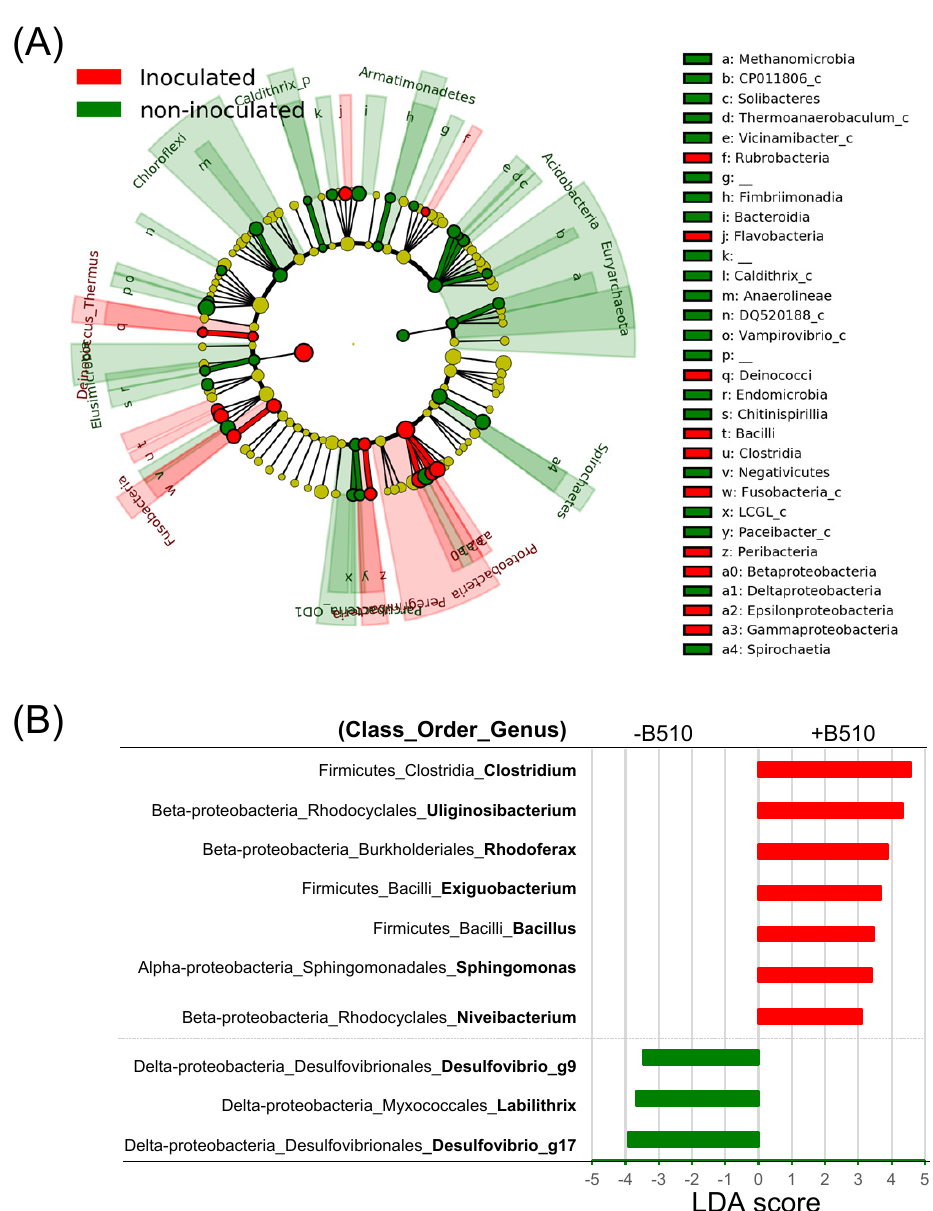
Figure 3. Linear discriminant analysis effect size (LEfSe) method identifies the significantly different ( p < 0.05, Kruskal-Wallis test) bacteria at multiple taxonomic levels by comparing the community composition of non-inoculated and B510-inoculated rice roots in the non-fertilized ( − N) condition. ( A ) A bacterial cladogram identifying the taxa with significantly different abundances between treatments are represented by colored Phylum, Class, Order and Family levels. The colored shadows represent trends of the significantly different taxa, B510-inoculated (red) and B510 non-inoculated (green). ( B ) LDA scores showed significant differences resulting from B510-inoculation. The red bars represent the significantly increased taxa, and green bars represent the decreased taxa resulting from B510-inoculation.